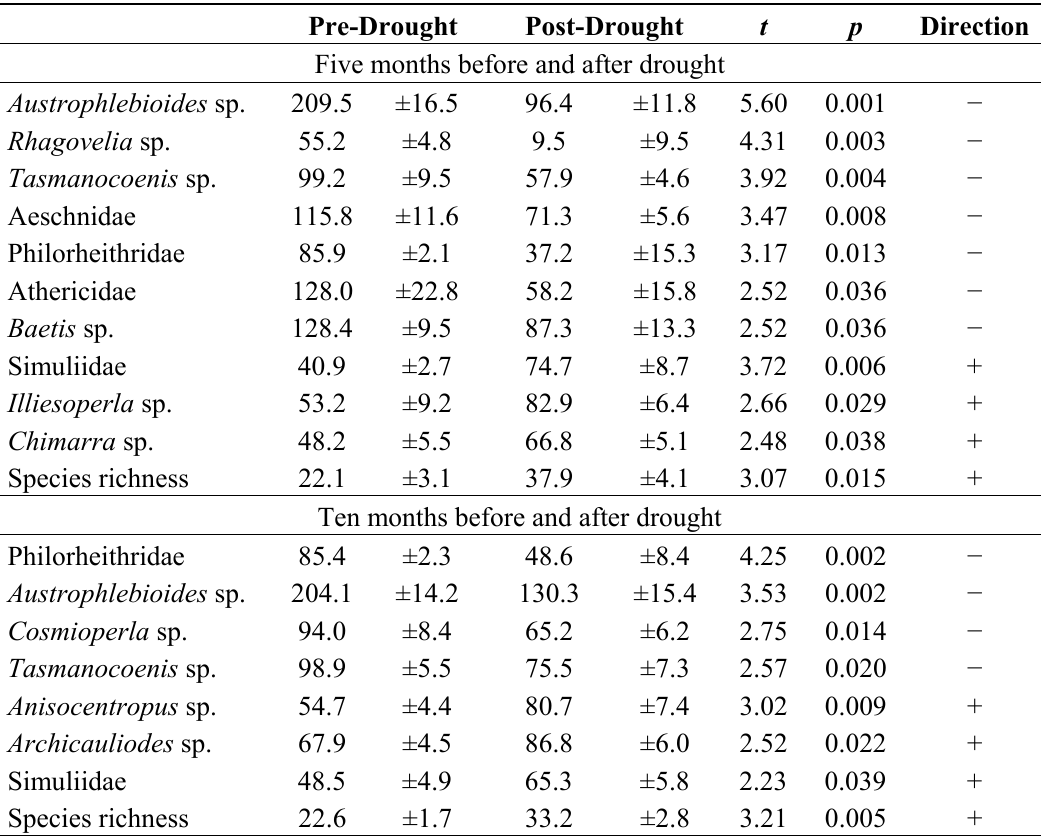
Table 2. Major differences ( t -test, p < 0.05) in coefficient of variation (mean % ± s.e.) of invertebrate abundance and species richness five months (d.f. = 8) and 10 months (d.f. = 18) before and after drought. Pre-Drought Post-Drought p Direction Five months before and after drought Austrophlebioides sp. Rhagovelia sp.